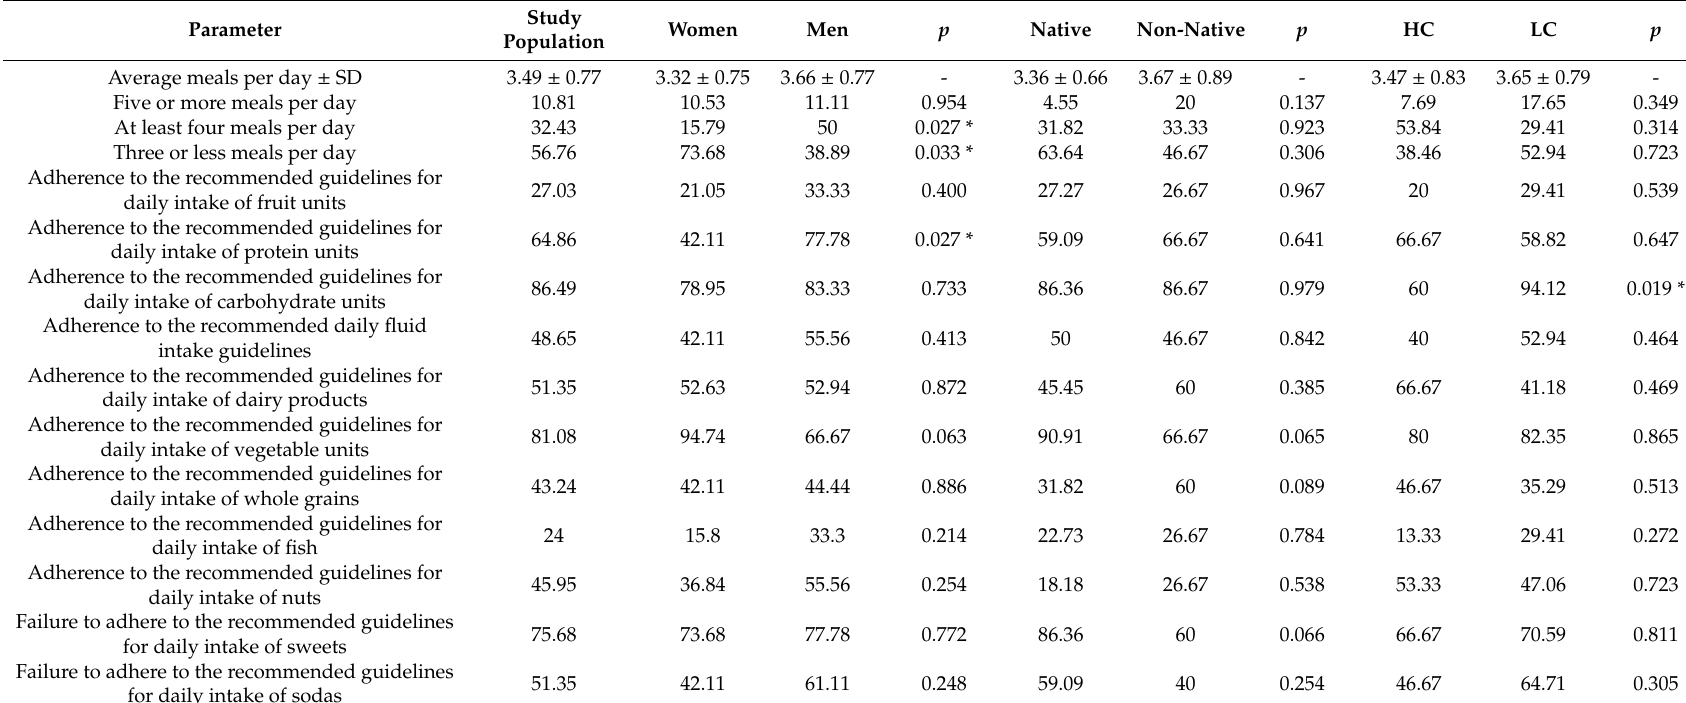
Table 4. General dietary habits of study